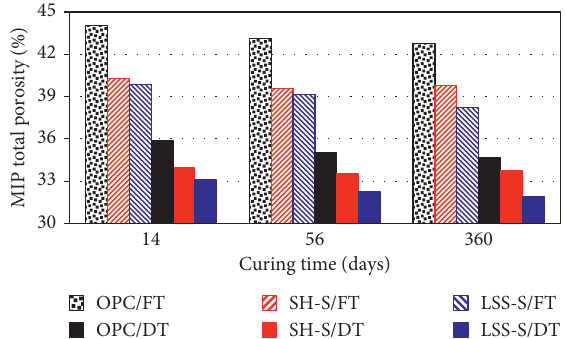
Figure 7: Effect of AAS and DTon the total porosity levels of